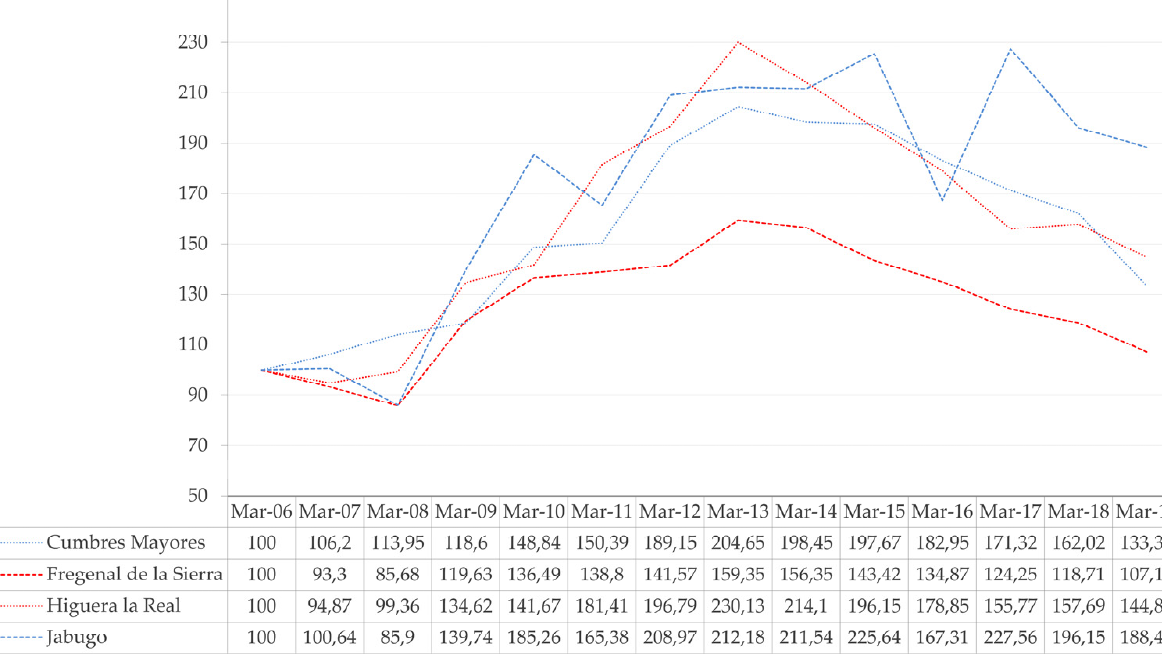
Figure 12. Unemployment rate by municipalities (2006 and 2019). Source: [102]. Authors own elab- oration.